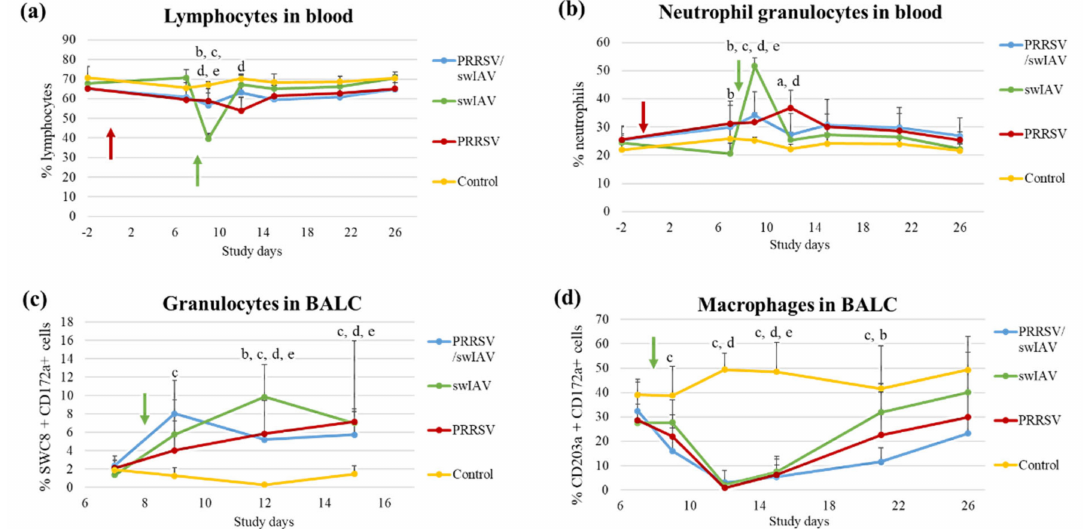
Figure 4. Immune cell proportions (percentages) in blood and among BALCs. ( a ) Blood lymphocytes. ( b ) Blood neutrophil granulocytes. ( c ) Granulocytes in BALC. ( d ) Macrophages in BALC. Data are reported as the mean ( ± standard deviation) percentages obtained from pigs ( n = 6) in the PRRSV/swIAV (blue), PRRSV (red), swIAV (green) and Control (yellow) groups. Letters indicate that significant differences (with p < 0.05) were obtained between PRRSV/swIAV and (a) PRRSV and (b) swIAV and (c) Control groups, (d) and (e) significant difference between PRRSV and swIAV and Control groups (respectively). SD0 (red arrow): PRRSV inoculation; SD8 (green arrow): swIAV